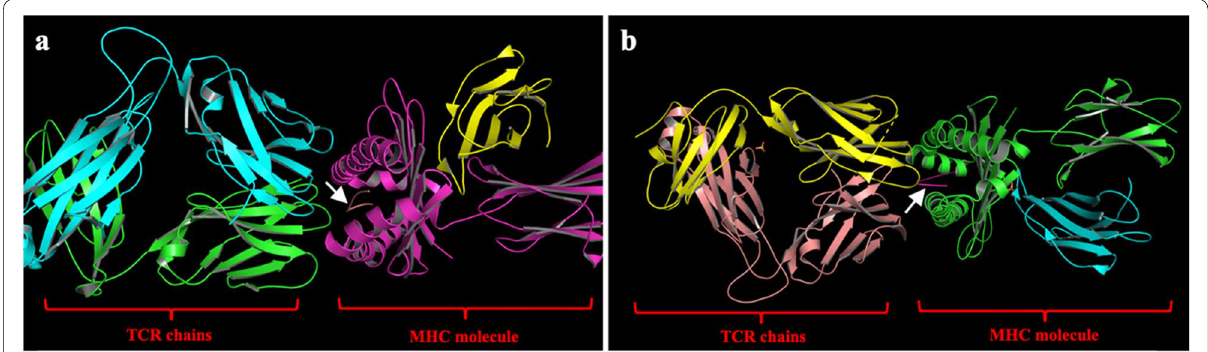
Fig. 1 The crystal structures of 5YXN and 4PRP. a 5YXN MHC molecule on the right side and TCR chains on the left side. b 4PRP MHC molecule on the right side, and TCR chains are on the left side. (white arrows indicate the co‑crystalized epitopes)